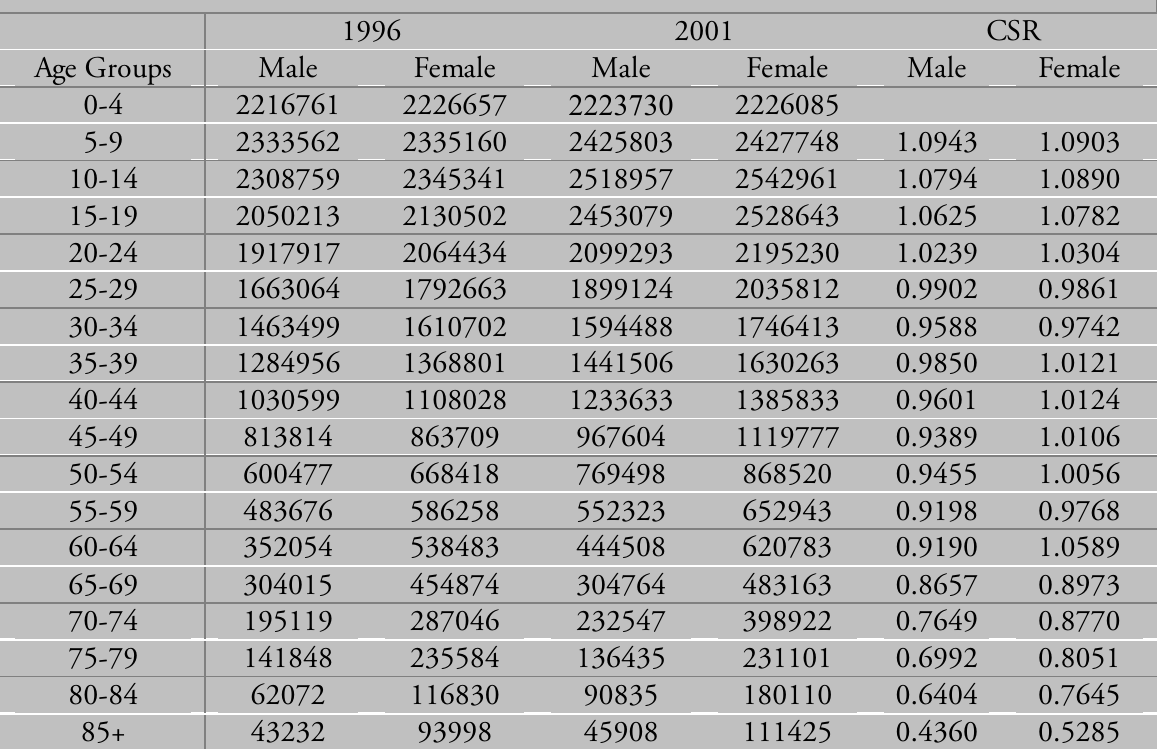
Table 1: Population of South Africa by Age and Sex and